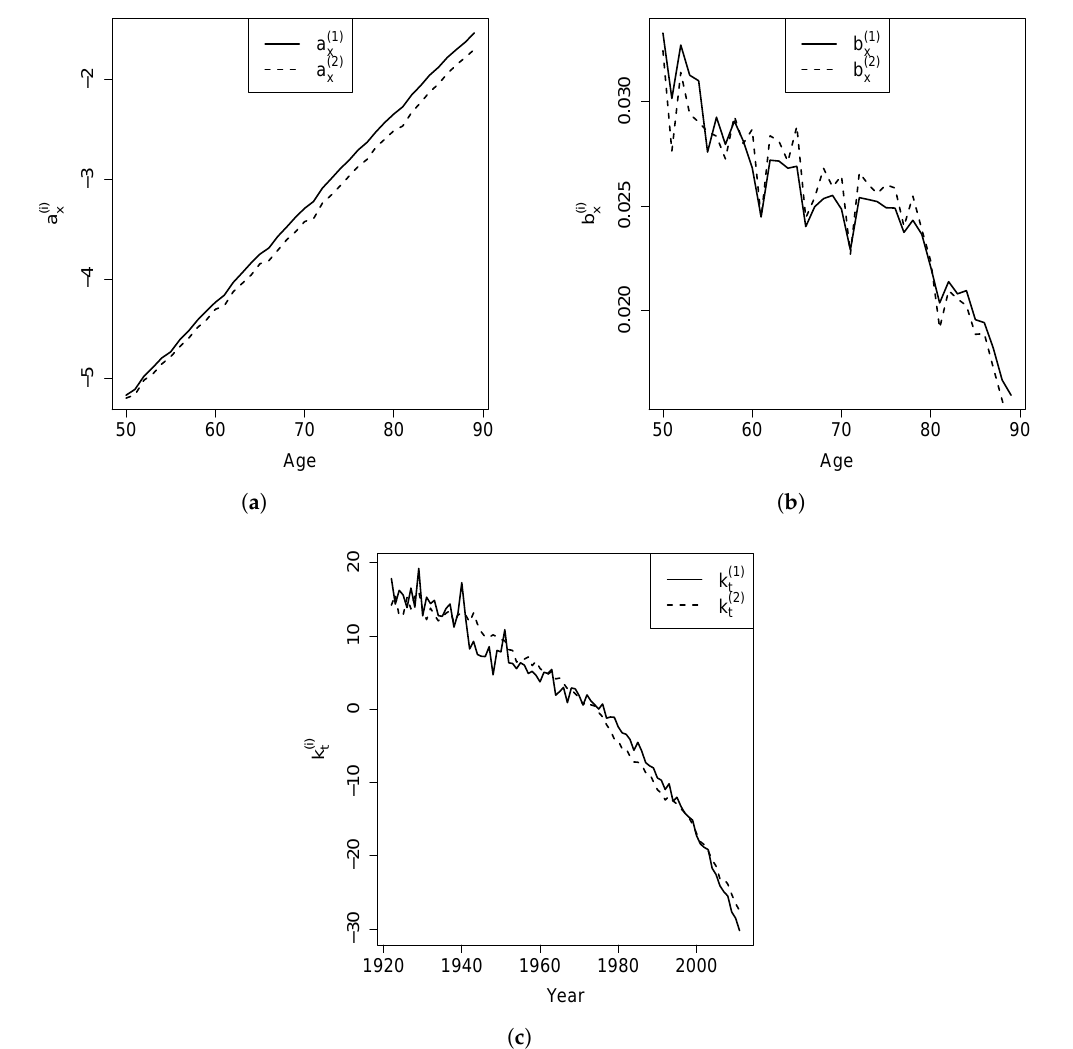
Figure 1. Parameter estimates of the Lee–Carter model using EW and Canadian mortality data. ( a ) Stand-alone age-specific parameters; ( b ) Age-specific parameters that interact with time-varying parameters; ( c ) Time-varying